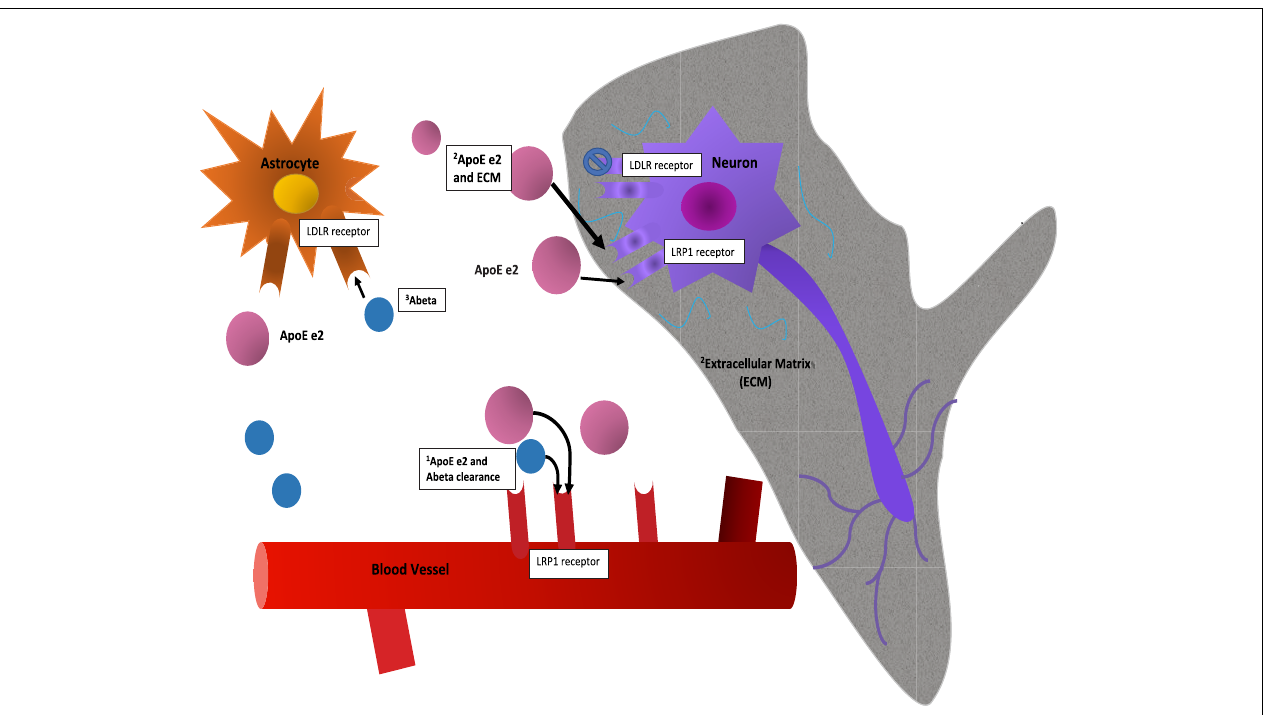
FIGURE 1 | Mechanisms. This figure is a speculative but neurobiologically plausible mechanistic model of how two established molecular properties of the e2 isoform, namely its protein abundance and its low affinity for the LDLR receptor, might provide initial stages of neuroprotection. While mRNA levels of the isoforms appear to be equivalent (Conejero-Goldberg et al., 2014), post translational differences due to isoform related susceptibility to cleavage or other degradation related processes result in full-length protein level differences (Riddell et al., 2008; Mahley, 2016). The mechanistic interpretation of such differences in brain are not established: Speculatively, protein abundance may have advantageous effects in and of itself by way of clearance of Ab, including via the BBB, or delivery of cholesterol to neurons for synaptic maintenance. As a caveat to this, the e4 isoform may be “toxic,” so simply increasing abundance might not be advantageous. Second, neuroprotective effects may be associated with reduced binding at a primary cellular ApoE receptor, LDLR, with the corollary that more ApoE e2 is more available at other receptors, such as LRP1 or ApoER2 and in parallel, allow other ligands to stimulate the LDLR receptor. These and other upstream (e.g., promoter variants) and downstream factors (e.g., isoform specific differences in lipidation, microglial activation, LTP reduction, etc.) are discussed elsewhere.